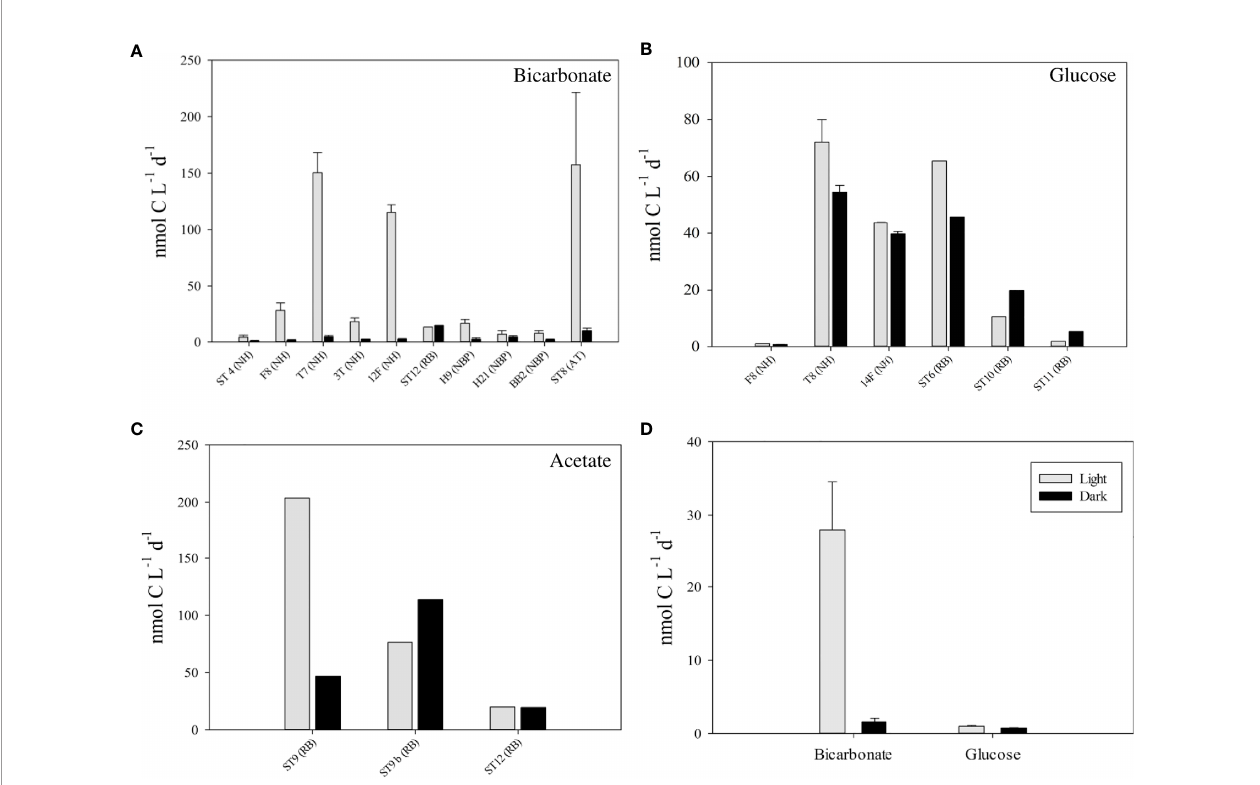
FIGURE 4 | Carbon assimilation rates for bicarbonate (A) , glucose (B) and acetate (C) during light (grey bars) and dark (black bars) incubations for several stations at the depth of the SCM (name of the cruise in parenthesis; NH is NH1410 cruise; RB is RB1603 cruise; AT is AT2626 cruise; NBP is NBP1305 cruise). Panel (D) represents C assimilation rates for bicarbonate and glucose during light (grey bars) and dark (black bars) incubations for the SCM at the station F8 in the cruise NH1410. Incubations lasted 12 hours. No incubations were performed in the LowpHOx I